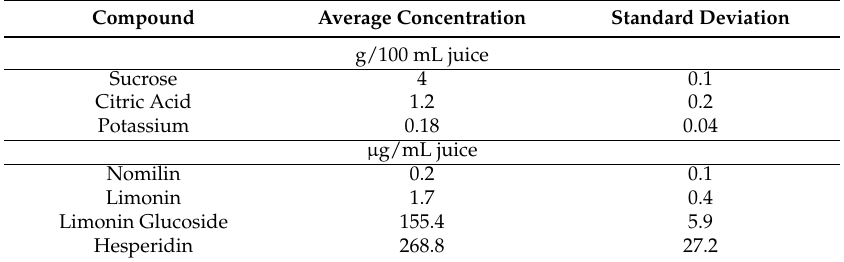
Table 1. Average concentrations and standard deviations of the compounds in base orange